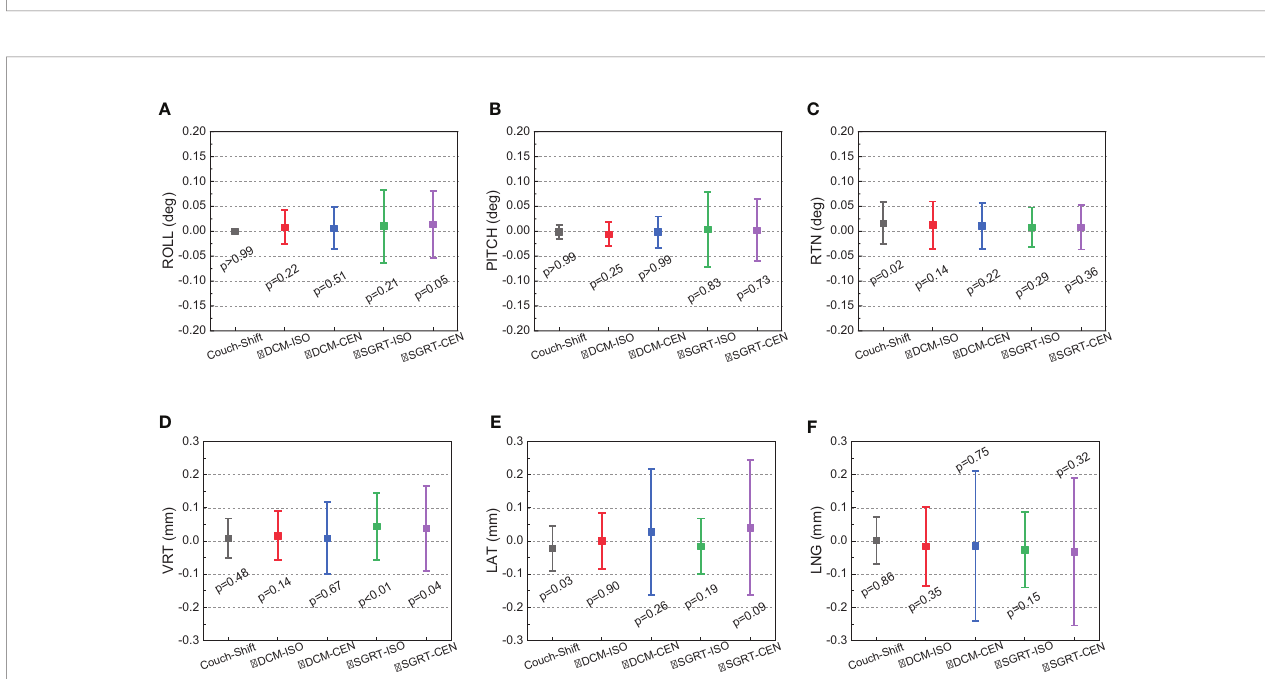
FIGURE 4 | Mean, standard deviation (error bars) of the discrepancies from the CBCT-guided shifts to the actual couch shifts and AlignRT trackings. The mean and stand deviation values are listed in 6 dimensions respectively: (A) ROLL (deg), (B) PITCH (deg), (C) RTN (deg), (D) VRT (mm), (E) LAT (mm) and (F) LNG (mm).